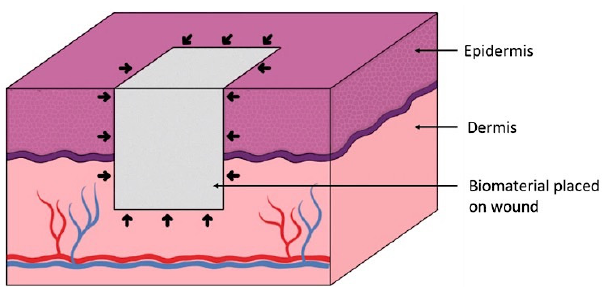
Figure 2. Scheme of the in vivo process of cell infiltration (black arrows) from the wound bed and edges into a skin scaffold.